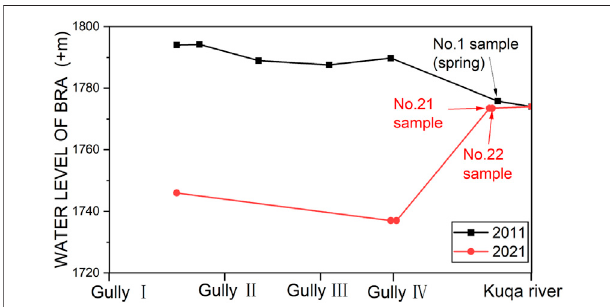
FIGURE 12 | Borehole water level variation in 2011 and 2021.